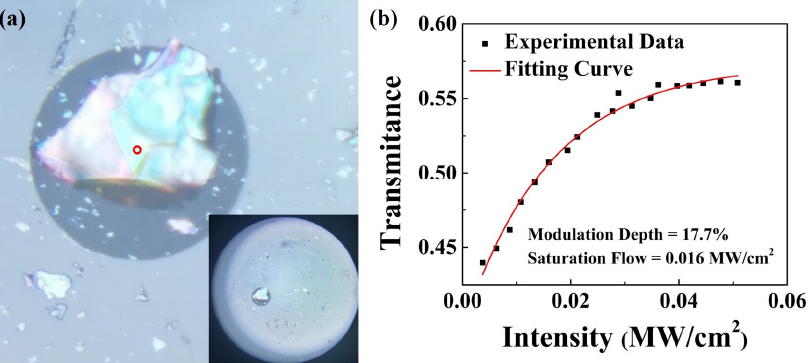
Figure 3. ( a ) Mn 3 Si 2 Te 6 saturable absorber on the edge of optical fiber. ( b ) nonlinear transmittance of the Mn 3 Si 2 Te 6 saturable absorber at different light